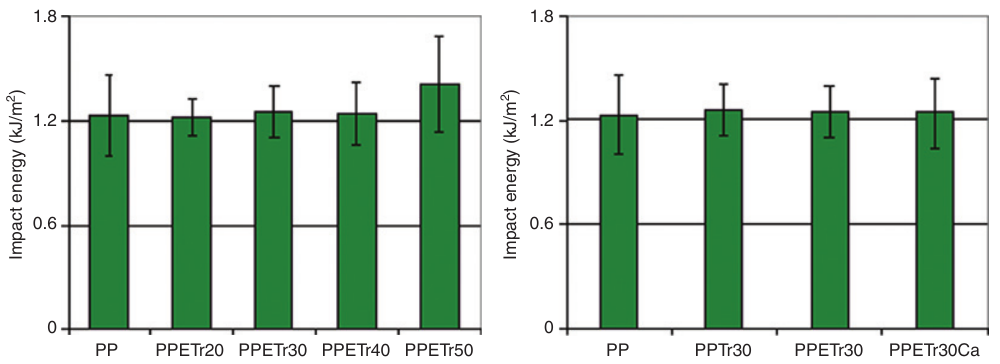
Figure 10 Notched Izod impact strength of PP triticale composites for different triticale concentrations and